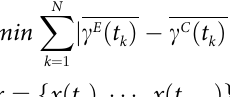
-norms for all ROIs are 2